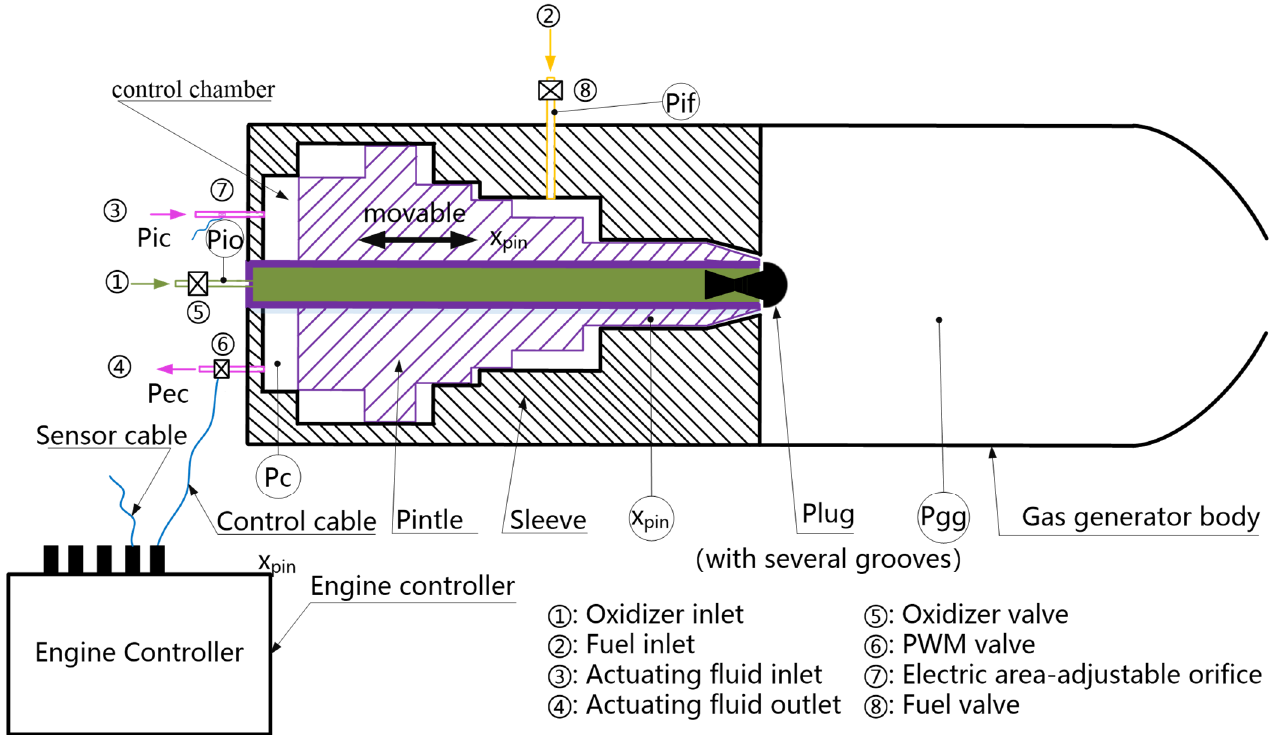
Figure 2. Working principle of the variable-thrust LRE IFRGG.